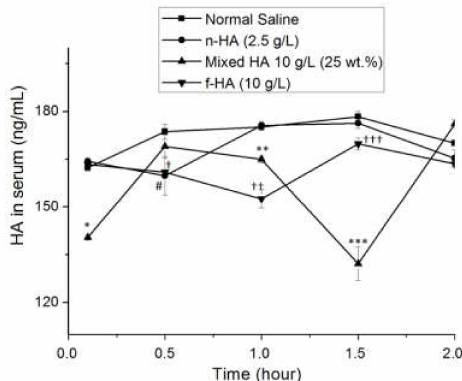
Figure 8. Kinetic behavior of HA clearance in the serum of rats perfused with HA formulations. The cumulative exogenous HA in the serum pool during perfusion. Error bars represent (standard deviation) SD = 3. The Student’s t -test was used to analyze data for significant di ff erences. Values of p < 0.05 were regarded as significant. Significant statistical di ff erence was identified for HA formulations: † , †† and ††† p < 0.05 for f-HA (10 g / L), # p < 0.05 for n-HA (2.5 g / L), *, ** and *** p < 0.05 for Mixed HA 25 wt.% n-HA (10 g / L), compared to the same time point in the normal saline